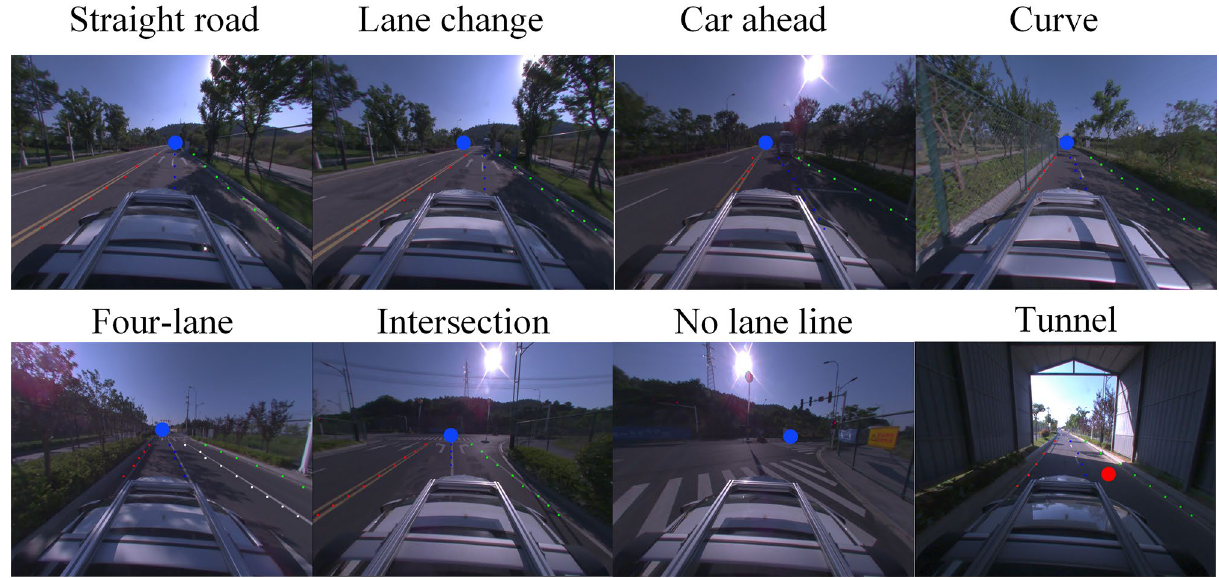
Figure 7. Vanishing point detection under eight road